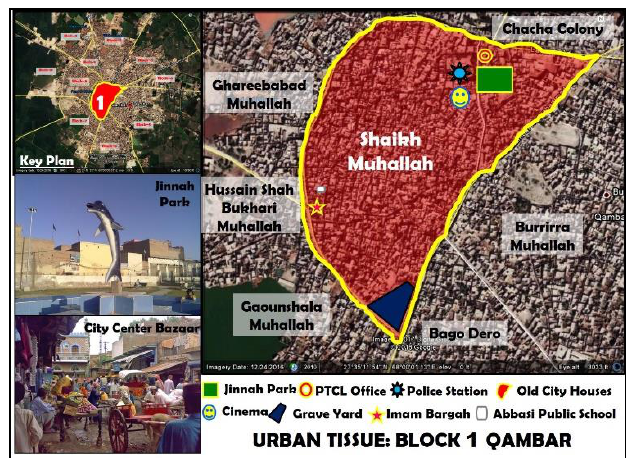
Fig. 5. Typo–Morphological analysis of Qambar: mapping urban tissues of city and its centre.